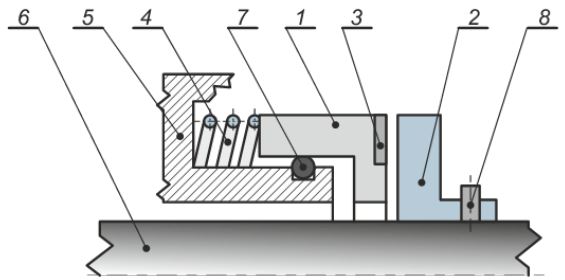
Fig. 1. Schematic cross section drawing of a non-contacting gas face seal; 1 – stator, 2 – rotor, 3 – groove, 4 – spring, 5 –